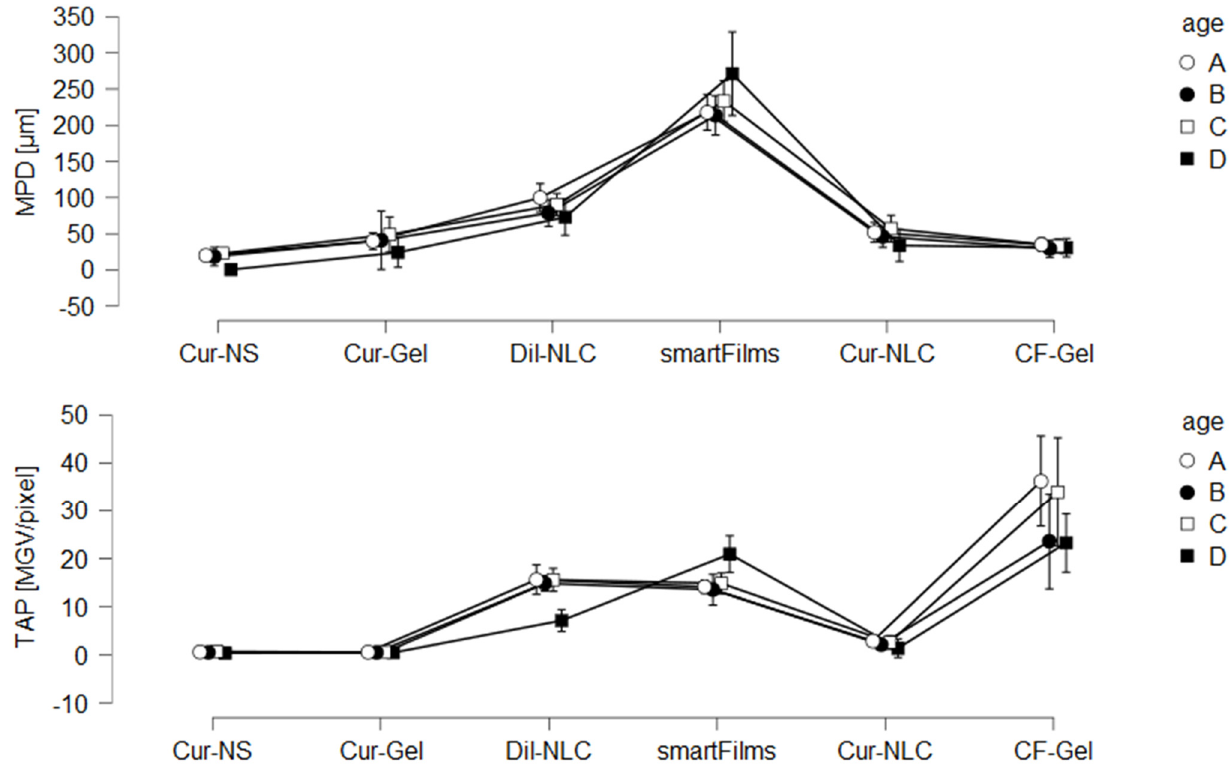
Figure 10. Comparison of influence of pig ear age (A = fresh ears, B = ears stored for 24 h before use, C = ears stored for 48 h before use, D = freshly frozen ears and on-demand thawing) on dermal penetration efficacy (MPD and TAP).